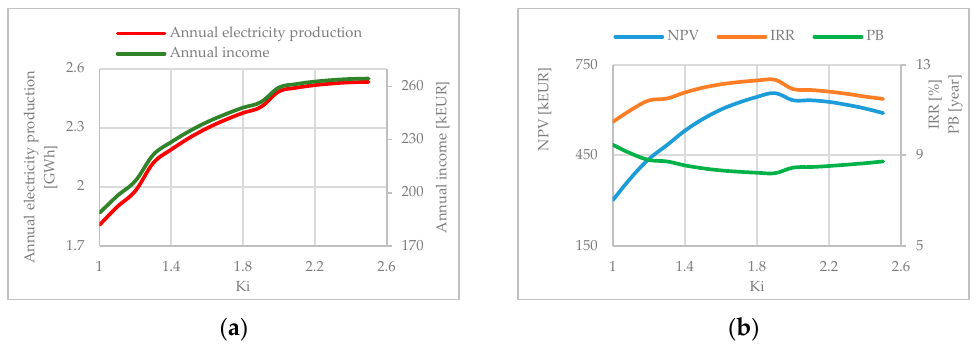
Figure 3. ( a ) Annual electricity production and income—Jasi č je SHPP; ( b ) NPV, IRR, and PB—Jasi č je SHPP.